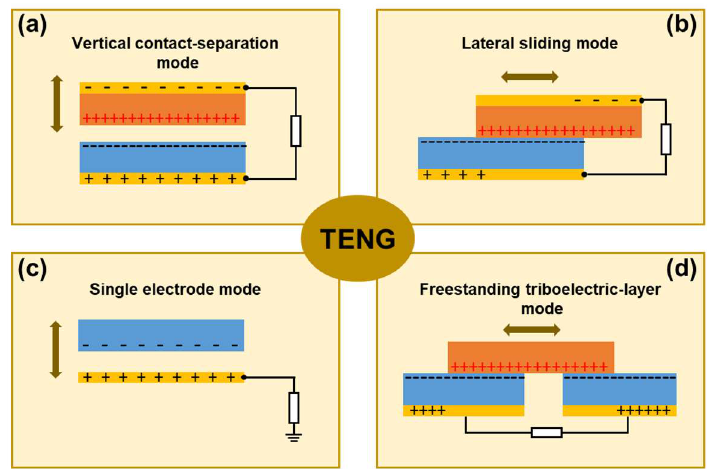
Figure 2. The four fundamental operation modes of the triboelectric nanogenerators. ( a ) The vertical contact-separation mode. ( b ) The lateral sliding mode. ( c ) The single-electrode mode. ( d ) The free-standing mode.